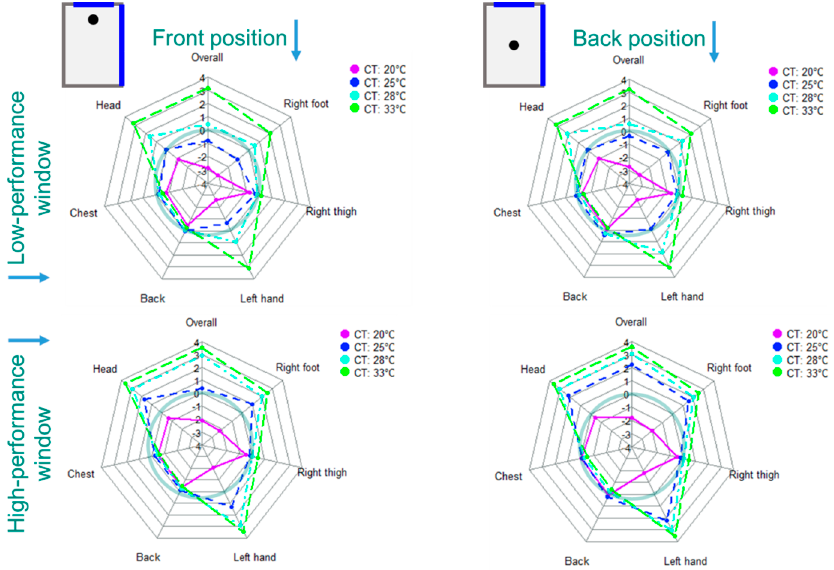
Figure 15. Overall and local thermal sensation at selected body limbs in the corner room with two facades influenced by ceiling temperatures, quality of facades and the position of the manikin. Nine-point thermal sensation scale: “very cold, − 4”, “cold, − 3”, “cool, − 2”, “slightly cool, − 1” to “neutral, 0” then to “slightly warm, +1”, “warm, +2”, “hot, +3” and “very hot, +4”.